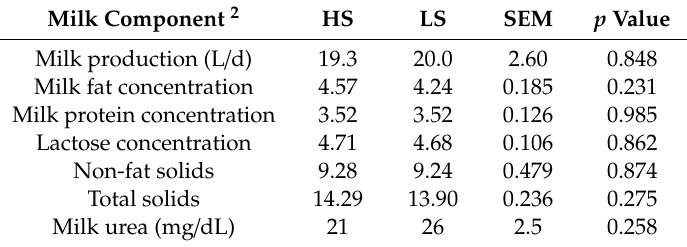
Table 3. Milk production and composition from dairy cows grazing on a perennial ryegrass pasture with high (32.2% DM 1 , HS) and low (22.4% DM, LS) contents of water-soluble carbohydrates 1 .